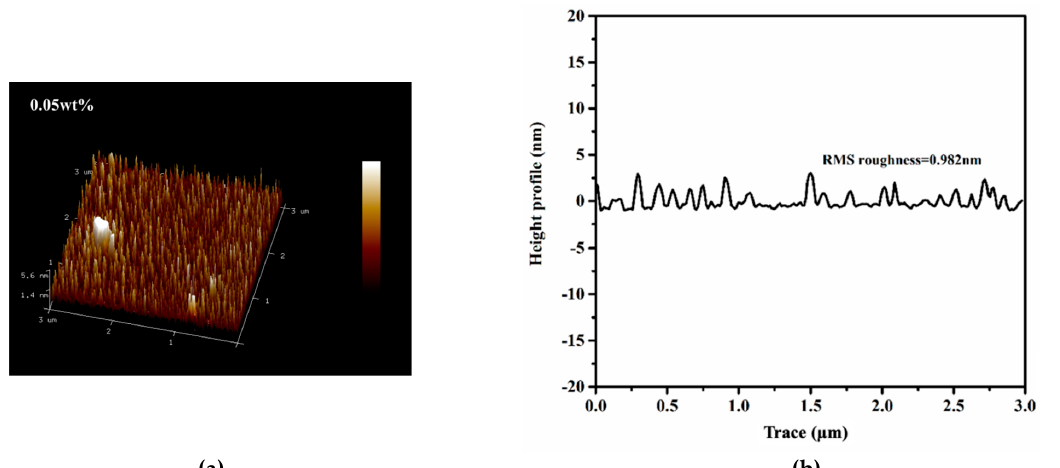
Figure 4. The 3D topographic AFM image ( a ) and corresponding height profiles ( b ) of the 0.05 wt % of the CNT-PDB film on the silicon substrate.